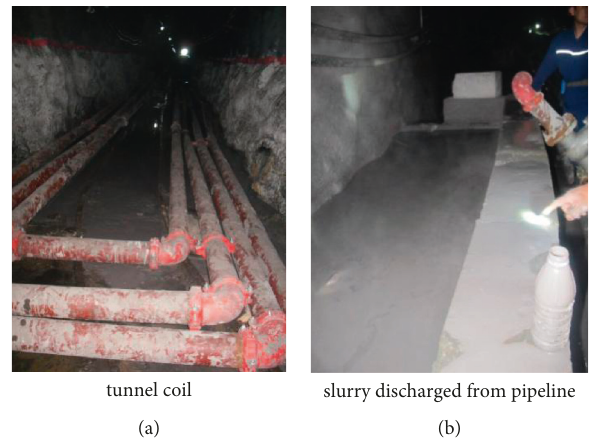
Figure 5: Experimental scene of large gravity flow. (a) Tunnel coil. (b) Slurry discharged from